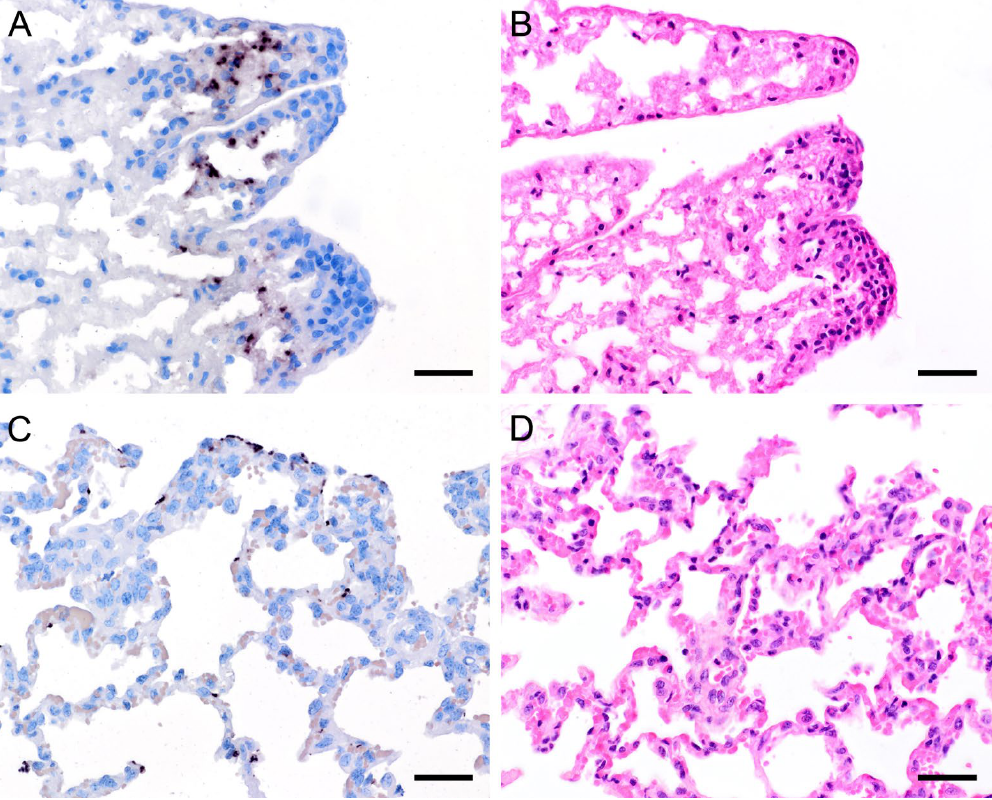
Figure 7. Adjacent sections from the same lung area of a European shrew and horse with mild colonization with Pneumocystis spp. are shown in comparison after ISH and H&E staining. ( A ) ISH labels single Pneumocystis organisms attached to the alveolar walls of the lungs of a European shrew. The rest of the tissue section is Pneumocystis negative. Bar = 40 µm; ( B ) H&E staining reveals an interstitial pneumonia. Bar = 40 µm; ( C ) ISH signals are diffusely distributed over the entire lung tissue section of a horse. Bar = 40 µm; ( D ) H&E staining reveals an interstitial pneumonia. Bar = 40 µm.